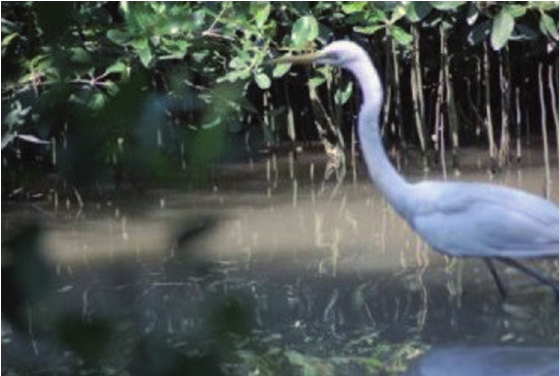
Fig. 7. Animal found in the mangrove area.